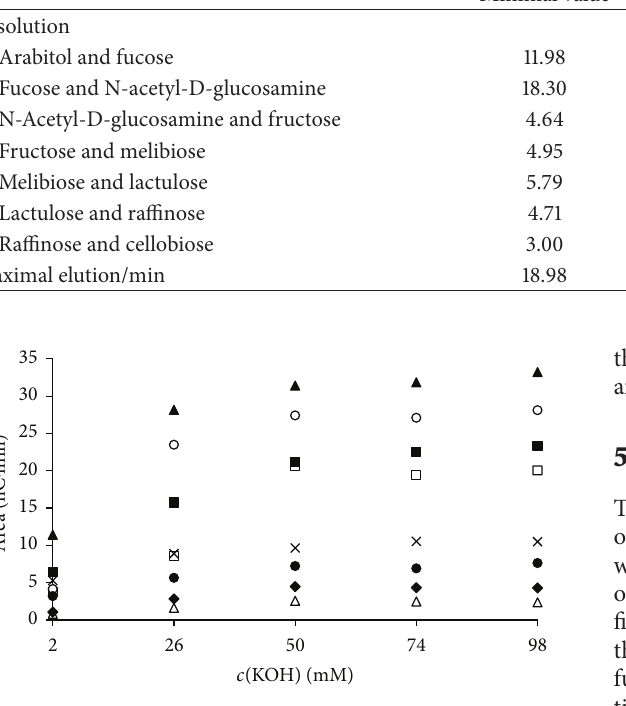
Figure 6: Peak areas for five isocratic experiments. The components are marked as follows: arabitol ( X ), cellobiose ( 󳵳 ), fructose ( ◻ ), fucose ( △ ), lactulose ( I ), melibiose ( × ), N-acetyl-D-glucosamine ( ∙ ), and raffinose ( ◼